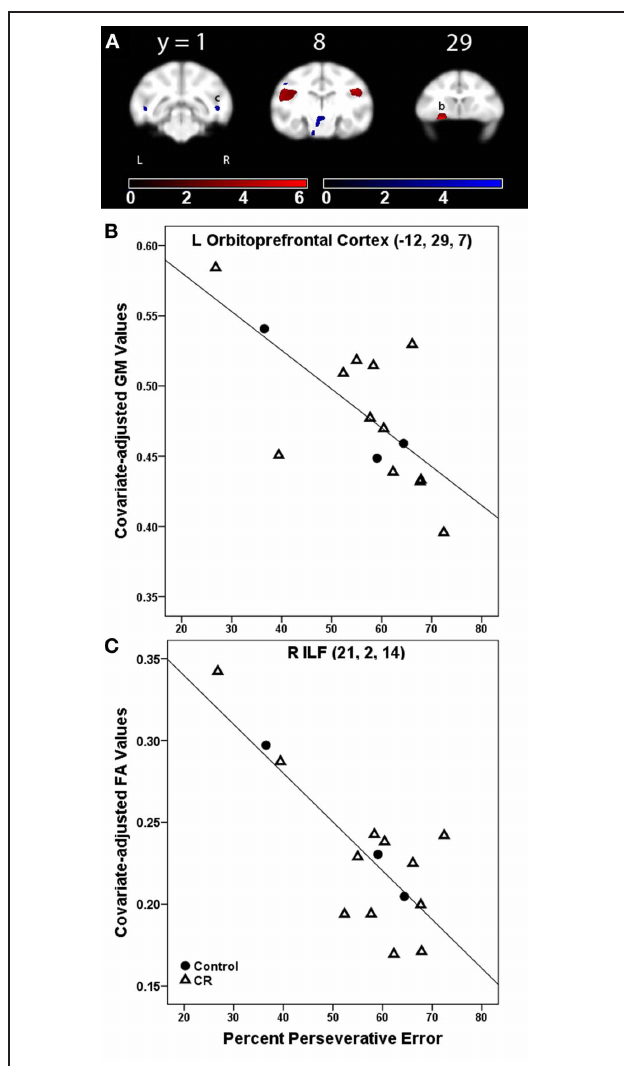
FIGURE 2 | (A) Statistical parametric map of the t -contrast displayed on coronal slices showing regions where higher percent perseverative error was correlated to less gray matter (GM, red) and lower fractional anisotropy (FA, blue) values for all animals (controls and CR). All comparisons include age and global signal variable as covariates. The probability threshold for each t -contrast was p < 0 . 005 (uncorrected). The color bars represent the value of the t -statistic. The left side of the brain is on the left in the images. (B) Plot of the negative correlation between perseverative error and regional GM in left orbitoprefrontal cortex, labeled as (b) in (A) . (C) Plot of the correlation between higher perseverative error and lower FA at the right inferior longitudinal fasciculus [ILF, labeled as (c) in (A) ].